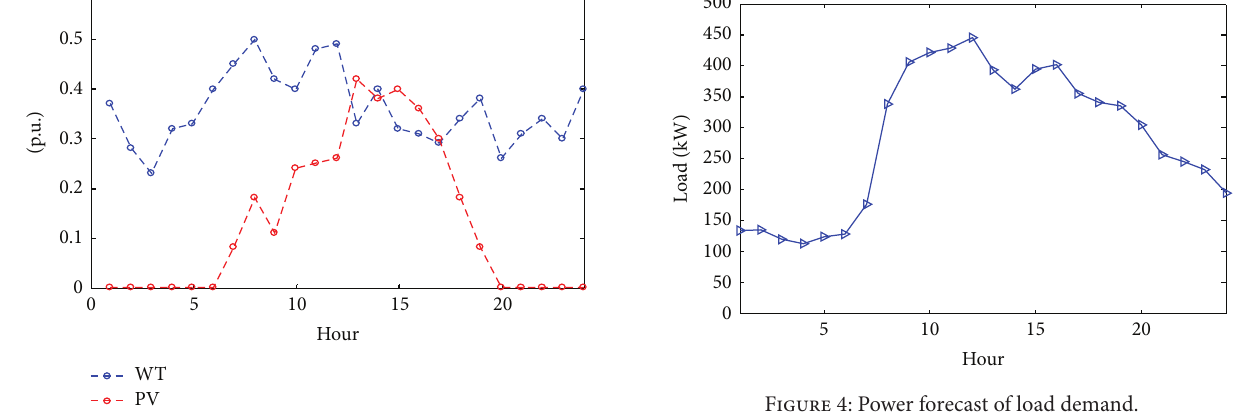
Figure 3: Power forecast of renewable energy generation. (5 p.m.–7 p.m.) approaches, the energy mix changes again.